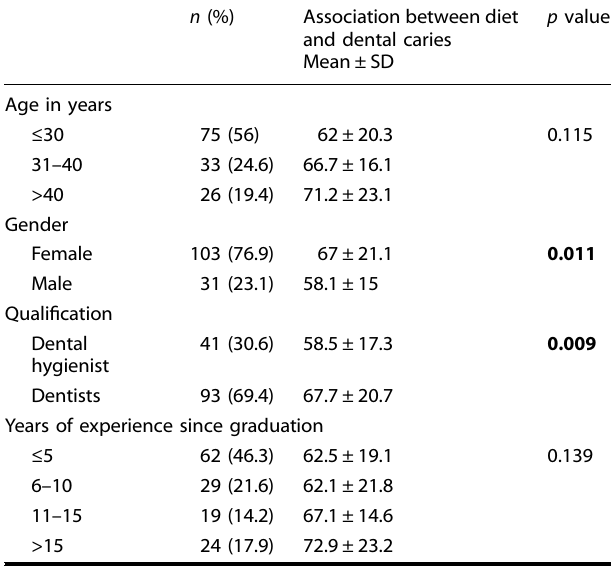
Table 2. Demographic characteristics (total = 134) and relationship between demographic characteristics and knowledge score of association between diet and dental caries.